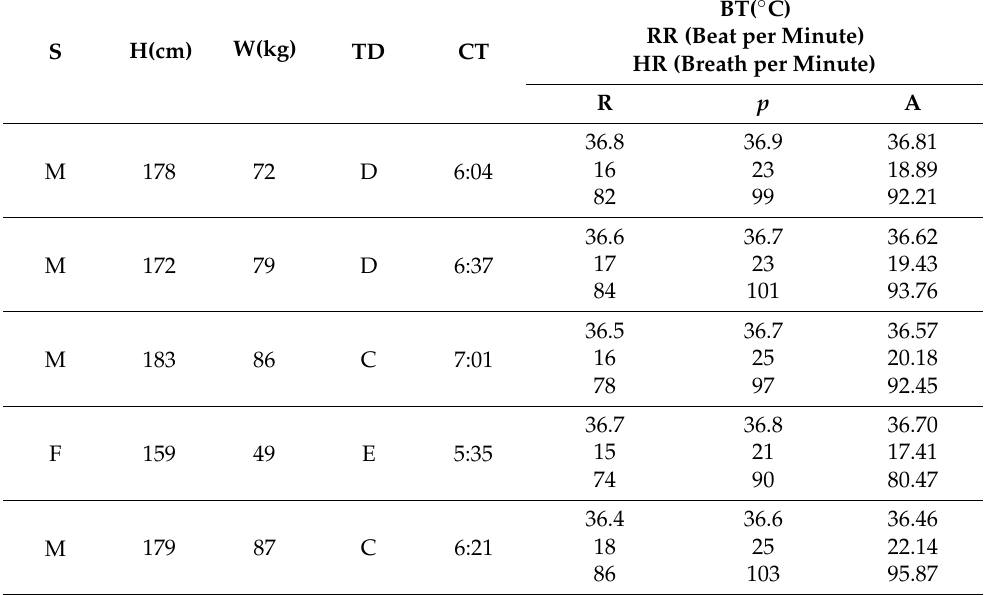
Table 1. Record of eight subjects.